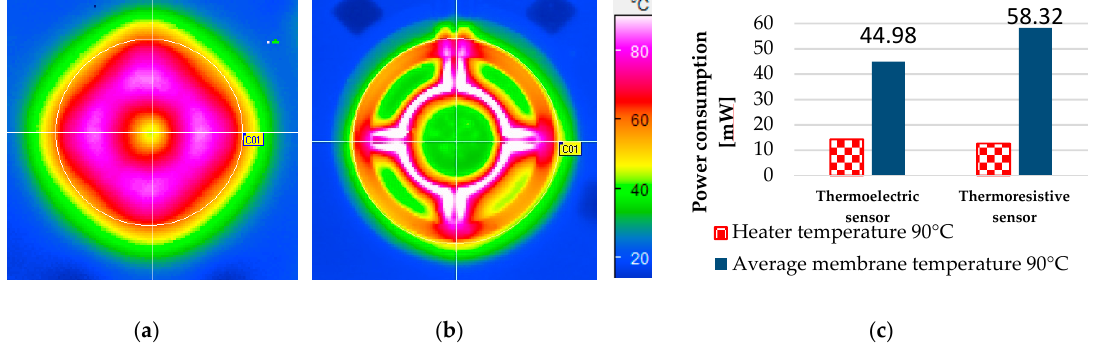
Figure 8. Temperature field on the membrane with IR camera measurement ( a ) thermoelectric sensor; ( b ) thermoresistive sensor, ( a ) is more homogeneous than ( b ); ( c ) comparative power consumption of the thermoelectric and the thermoresistive sensor [38].